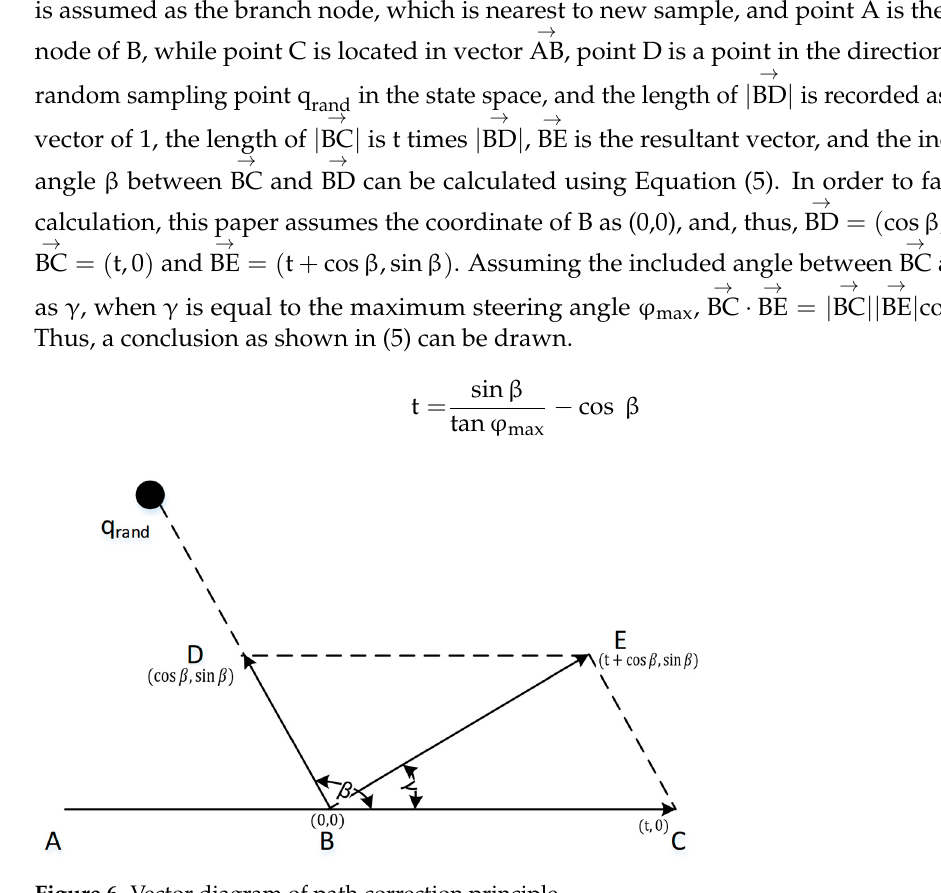
Figure 6. Vector diagram of path correction principle.